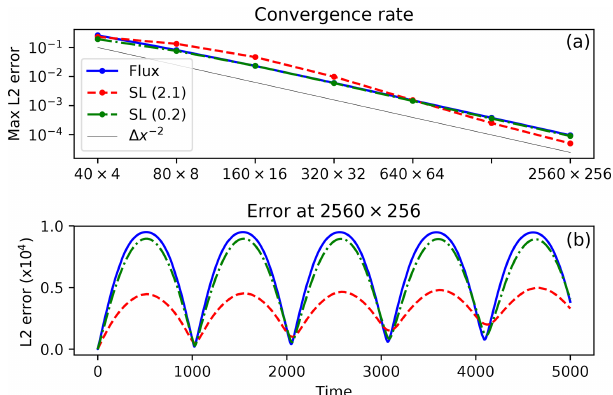
Figure 3. (a) Maximum L2 error, i.e. ( (cid:82) (σ − σ ex ) 2 d A/(L x L z )) 1 / 2 , over the integration period for the test case of Sect. 3.3 vs. resolu- tion for flux-form Eulerian advection with a Courant number of 0.2 (solid blue), semi-Lagrangian advection with a Courant number of 2.1 (dashed red), and semi-Lagrangian advection with a Courant number of 0.2 (dash-dotted green), showing second-order conver- gence (line). (b) L2 error over time for these algorithms, on the 2560 × 256